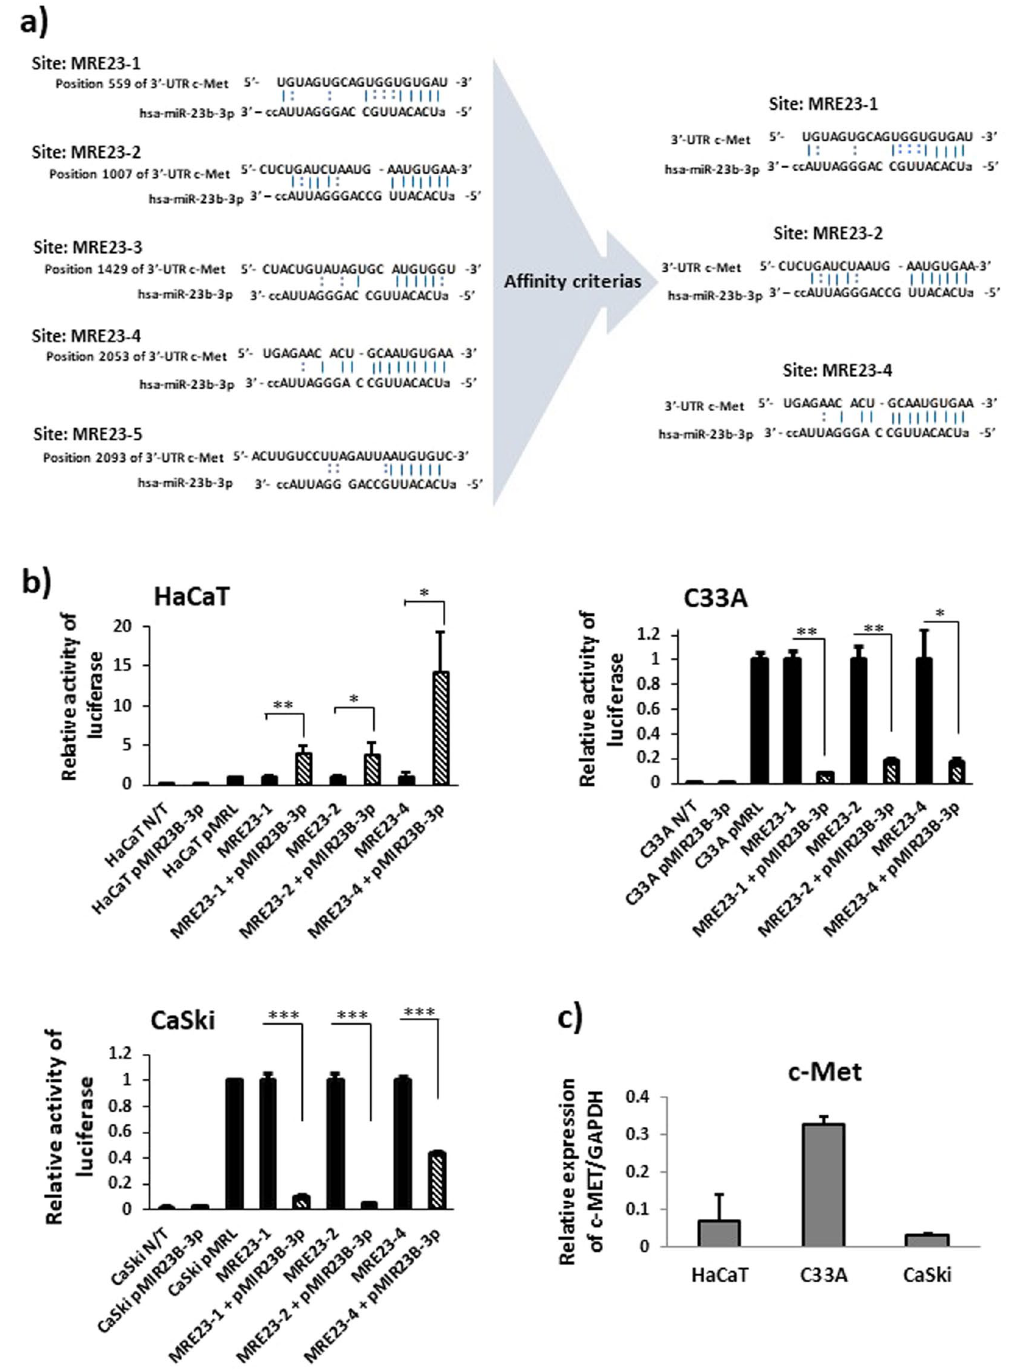
Figure 3. miR-23b-3p represses c-Met in C33A and CaSki cells through its interaction with three MRE sites from the 3 ′ -UTR region of c-Met. (a) The MRE23-1, MRE23-2 and MRE23-4 located in the 3 ′ -UTR region of c-Met mRNA are most likely to interact with miR-23b-3p. (b) c-Met is a direct target of miR-23b-3p in CC cells. The binding of miR-23b-3p to the three MRE23 sites inhibits luciferase activity in C33A and CaSki cells. The luciferase relative activity was detected 48 h post-transfection. N/T: non-transfected; pMRL: pMiR-Report- Luciferase (without DNA insert). * p < 0.05, ** p < 0.01, *** p < 0.001 compared to simple transfection. (c) The expression of c-Met was determined via RT-qPCR. The c-Met expression levels were normalized with GAPDH and analyzed via the Δ Ct method. The data were expressed as averages +